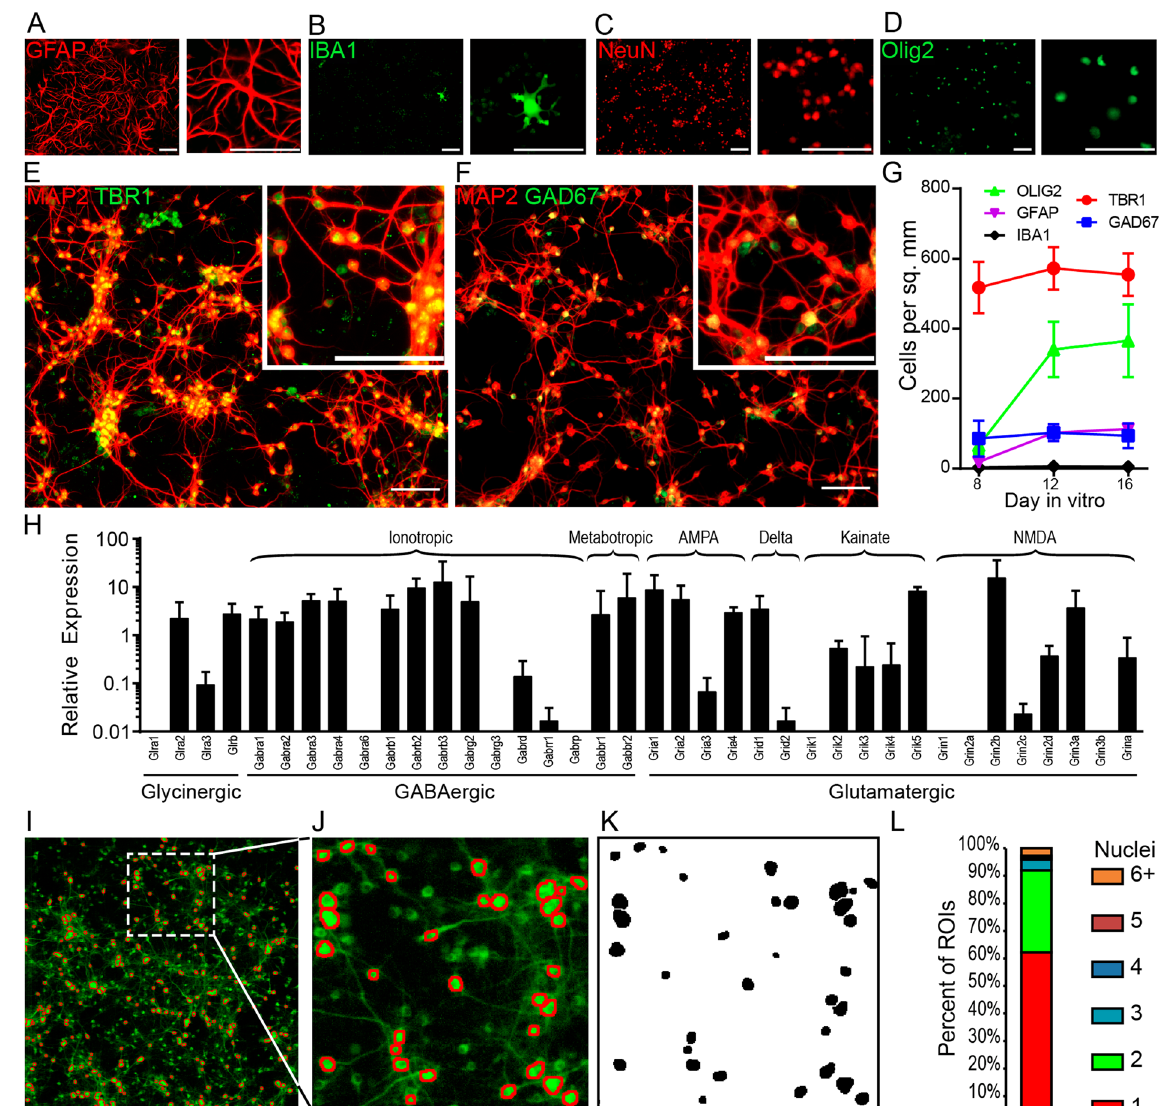
Figure 1. Automated GCaMP6f fluorescent image segregation for tracking neuronal calcium transients in high-density cultures. Representative immunostaining for ( A ) glial fibrillary acid protein (GFAP; astroglia), ( B ) ionized calcium binding adaptor molecule 1 (Iba1; microglia), ( C ) neuronal nuclei (NeuN; neurons), ( D ) oligodendrocyte lineage transcription factor 2 (Olig2; oligodendrocytes), ( E , F ) microtubule associated protein 2 (MAP2; neurons), ( E ) T-box brain 1 (TBR1; glutamatergic neurons), ( F ) glutamate decarboxylase molecular weight 67 kD (GAD67; GABA-ergic neurons). 10x fluorescent micrographs were acquired on DIV8, 12, and16 using an LSM 780 confocal microscope. Scale bar is 50 μ m. ( G ) Quantification of immunostaining for cellular markers from DIV8 to DIV16. Positively labeled cells were manually counted in 4–10 optical fields. Error bars are mean + / − 95% confidence intervals (CI). ( H ) The relative expression of excitatory and inhibitory neurotransmitter receptors in the cultures was determined by RTPCR. ( I – L ) Neuronal cultures were infected at plating with 2000 MOI of AAV1.Syn.GCaMP6f.WPRE.SV40. At time of acquisition culture plates were transferred to the stage of a Zeiss 5 Live spinning disc confocal microscope with environmental chamber. After brief environmental equilibration, 250 frames were captured by time series acquisition at 5 frames per second. Maximum intensity projections were generated from the time series and imported into ImageJ for automated region of interest (ROI) generation. ( I – J ) Maximum intensity projection of raw time series acquisition with derived ROIs overlaid in red. ( K ) Binary image masks used for generating ROIs in ( J , L ) To determine correspondence between ROIs and individual cell bodies, cells were counterstained with DAPI immediately prior to imaging. ROIs were generated and overlaid on maximum intensity projections. The number of DAPI + nuclei per ROI determined using ImageJ Cell Counter plugin for 494 ROIs. The percent of ROIs containing 1 or more nuclei is graphed. As shown, 90% of ROIs corresponded to 2 or fewer cell bodies. Findings are representative of two independent